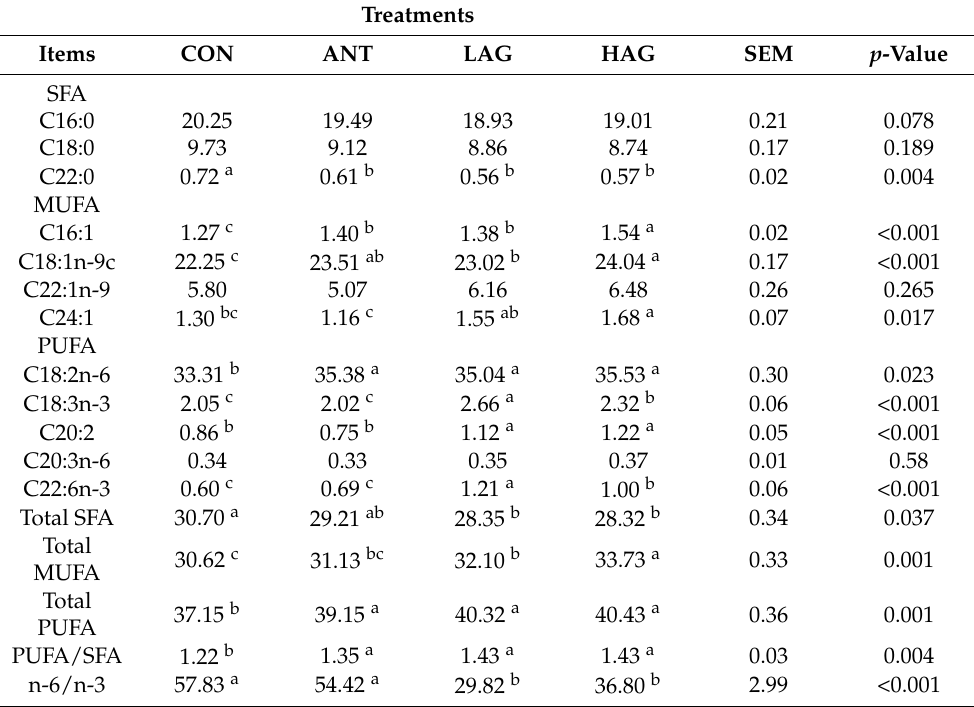
Table 4. Effects of Astragalus-Glycyrrhiza polysaccharides on the fatty acid composition of breast muscle. Treatments